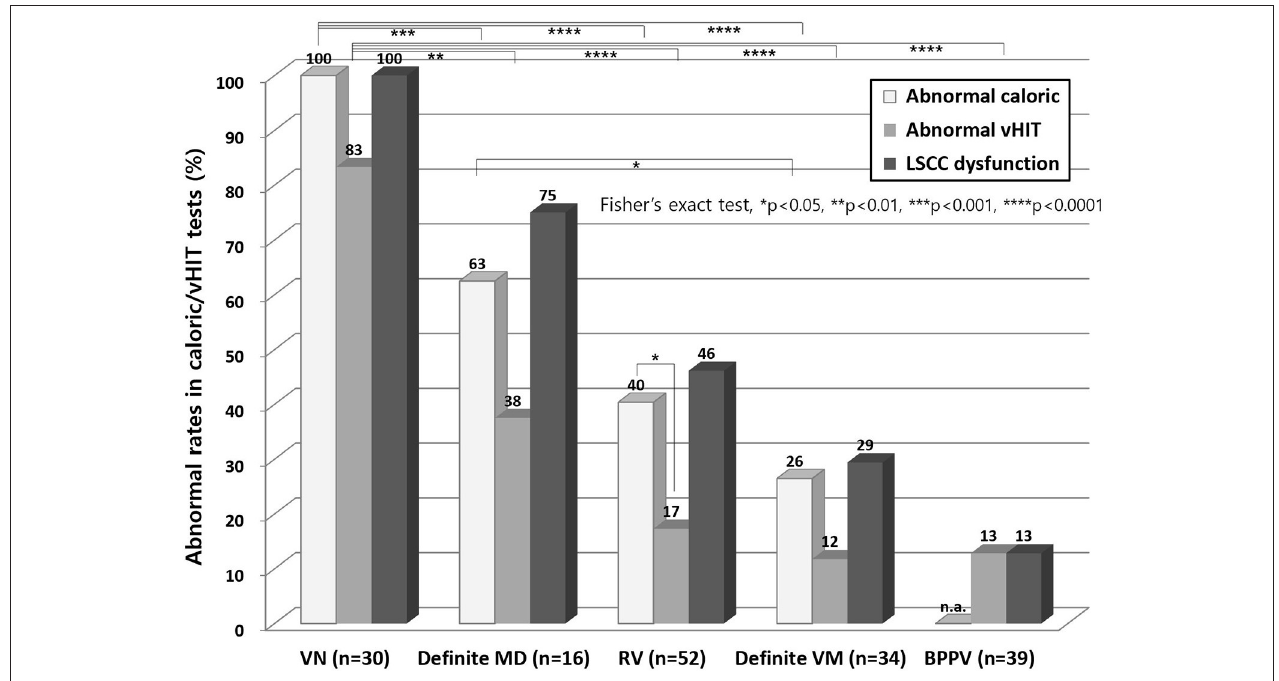
FIGURE 1 | Abnormal results from caloric test and vHITs. Abnormal caloric results were more common than abnormal vHIT findings in all vestibular disorders, although this was a significant finding only in RV. The abnormal caloric and vHIT results were highest in VN and decreased in the following sequence, definite MD, RV and definite VM. vHIT, video head impulse test; LSCC, lateral semicircular canal; n.a, not applicable; VN, vestibular neuritis; MD, Meniere’s disease; RV, recurrent vestibulopathy; VM, vestibular migraine; BPPV, benign paroxysmal positional